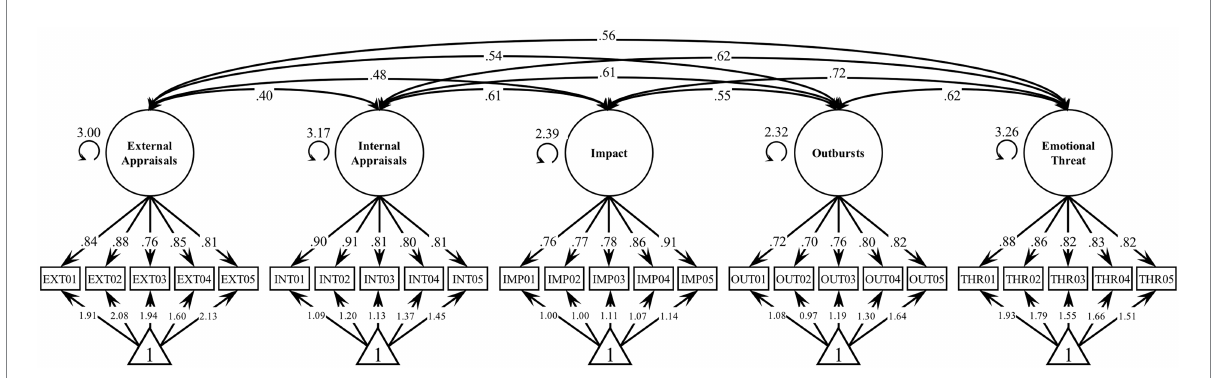
FIGURE 2 First-Order Factor Model of S-Five Scales. N = 639. All factor loadings, intercepts, and correlations are significant at p < 0.00006. Factor loadings and intercepts are completely standardized (both latent and observed variables). Unstandardized factor standard deviations are shown next to the latent variables.